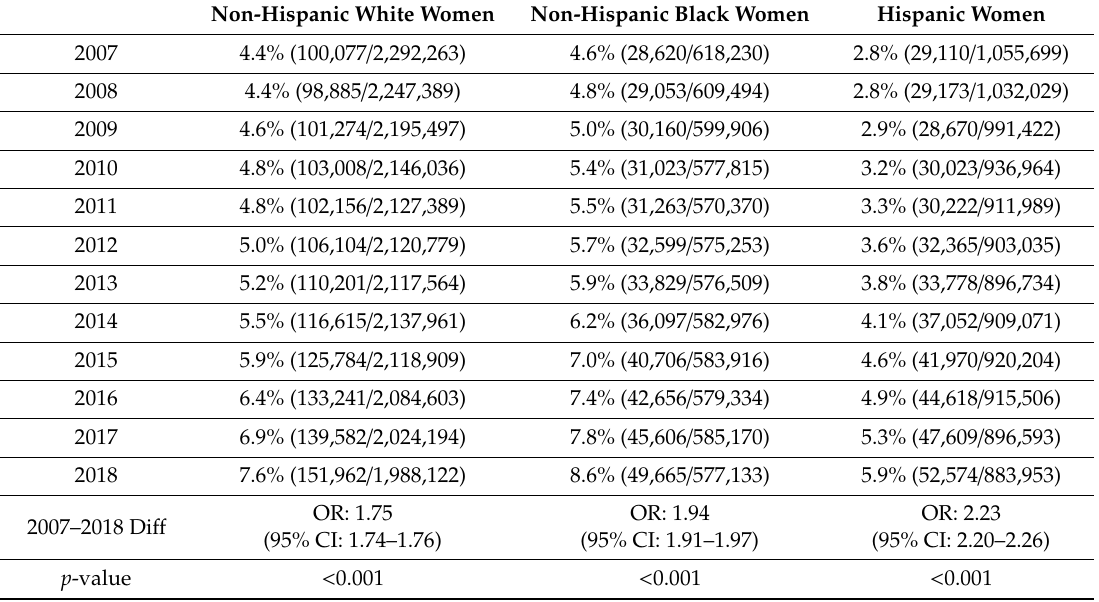
Table 1. Annual prevalence of hypertensive disorders of pregnancy (HDP) for 2007–2018, by racial / ethnic group.